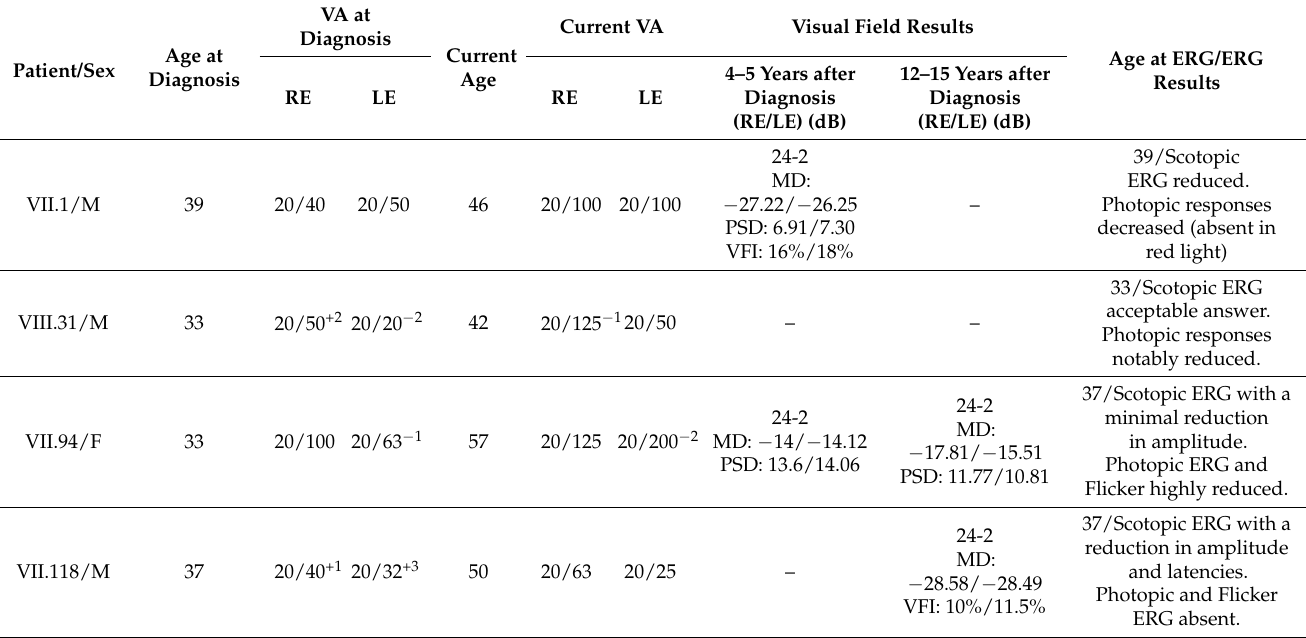
Table 1. Clinical